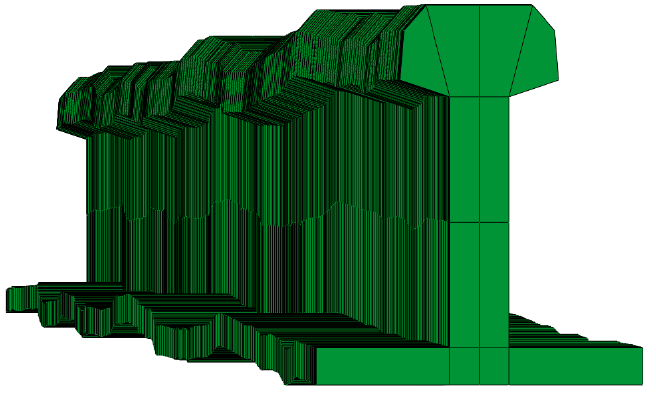
Figure 21. Details of the track model with irregularity.